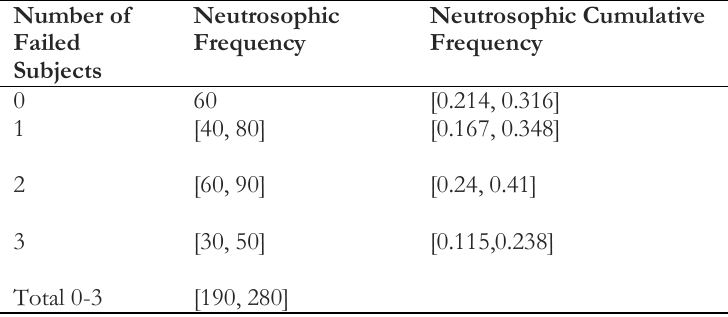
Table 1. Neutrosophic frequency